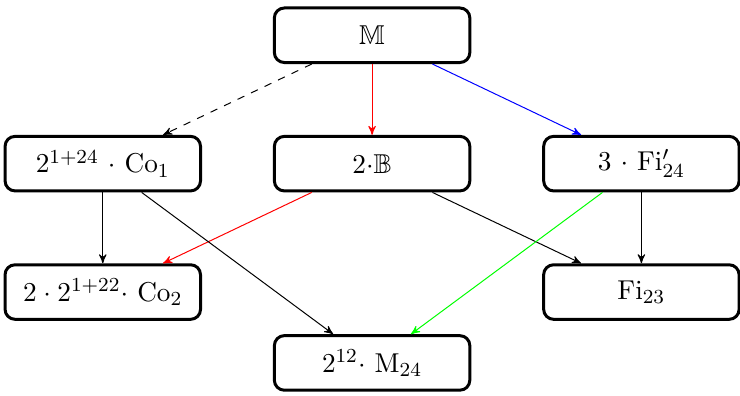
Figure 1 . Partial (cid:13)ows of maximal subgroups from the monster group M [16]. Each arrow from A to B implies that B is a maximal subgroup of